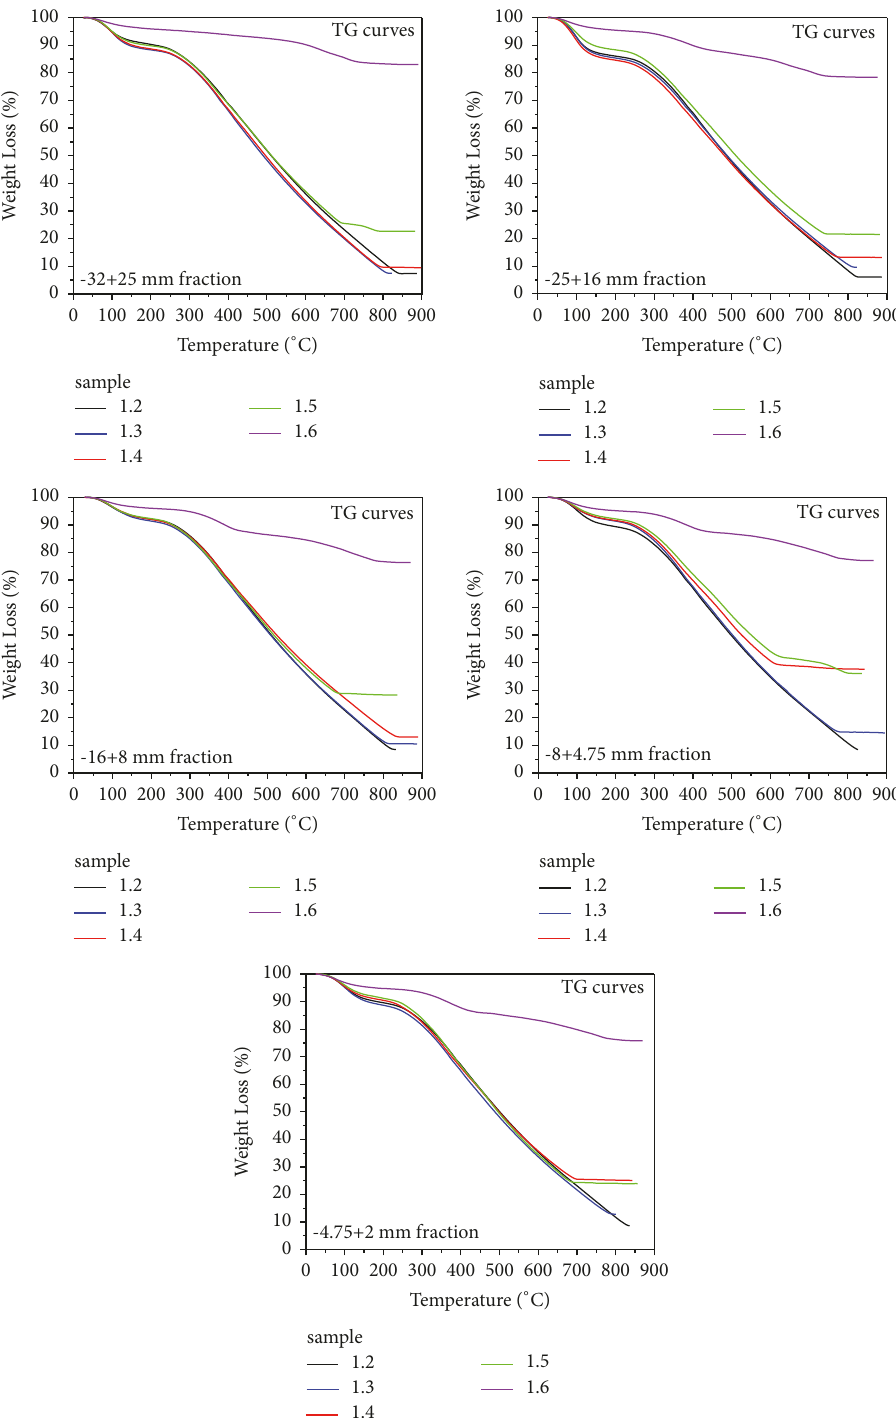
Figure 4: TG curves of floated materials for all fractions at different specific gravities of